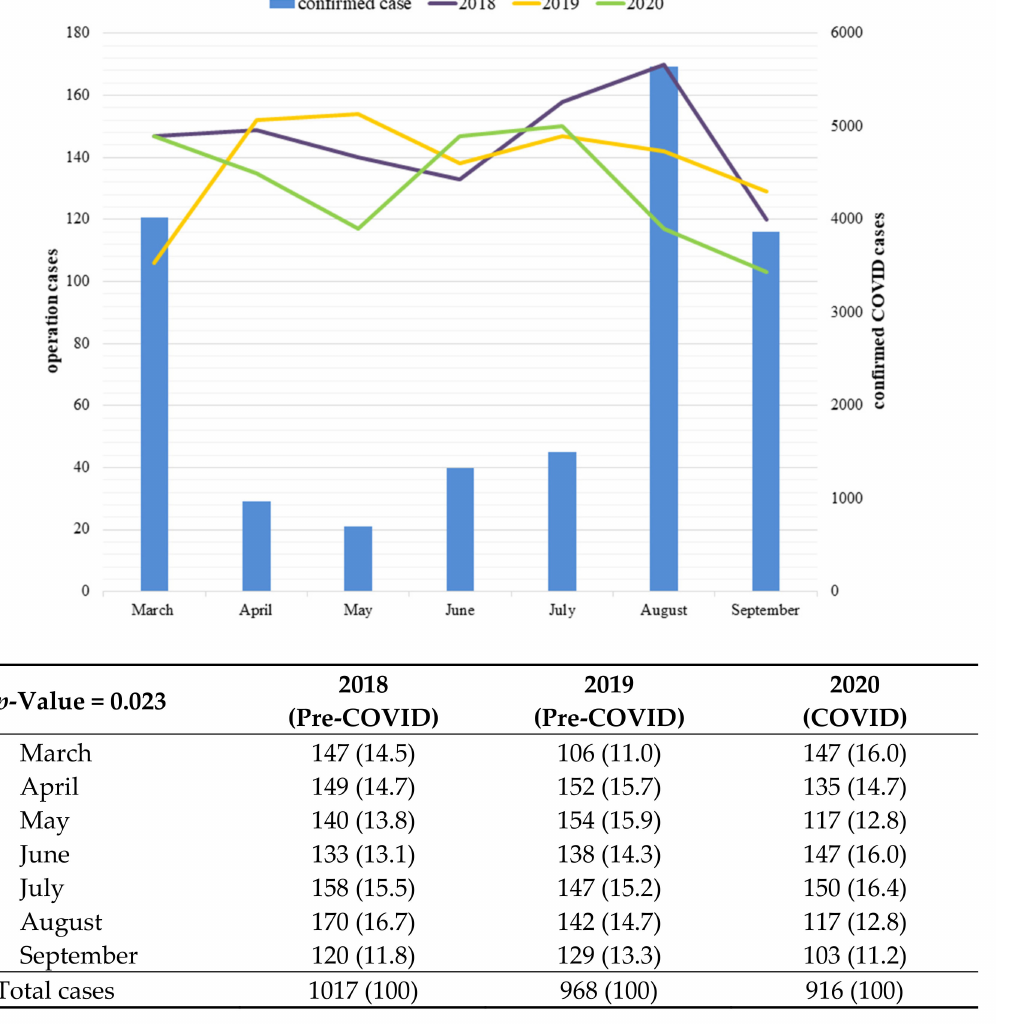
Figure 1. Monthly number of patients confirmed as having COVID-19 and undergoing colorectal cancer surgery from March through September 2018, 2019, and 2020. Patients with colorectal cancer who underwent surgical treatment between March and September 2020 (the COVID period) were compared with those who underwent surgical treatment between March and September 2018 and 2019 (the pre-COVID period). Table